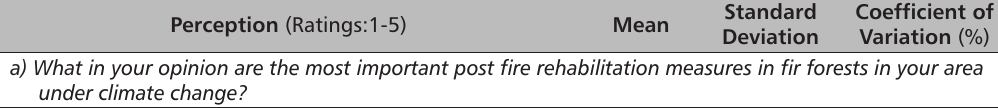
TABLE 6. Perspectives of post fire management measures for adaptation of fir forests under climate